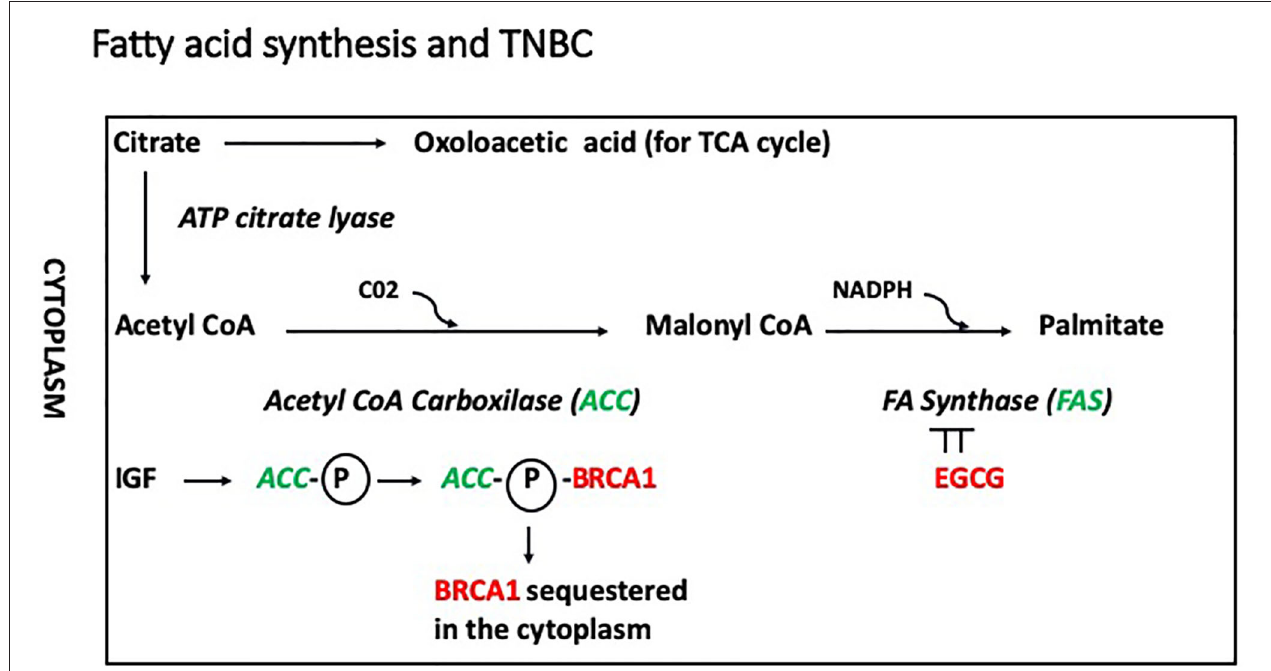
FIGURE 3 | In this model, IGF-1 induces phosphorylation of ACCA, and inhibits its association with BRCA1, which remains inactive in the cytoplasm. In addition, phosphorylated ACC would promote fatty acid synthesis inducing conversion of acetyl coA into malonyl coA. The conversion of malonyl coA into palmitate is mediated by the fatty acid synthase (FASN), which is inhibited by epigallocatechin-3-gallate (EGCG).